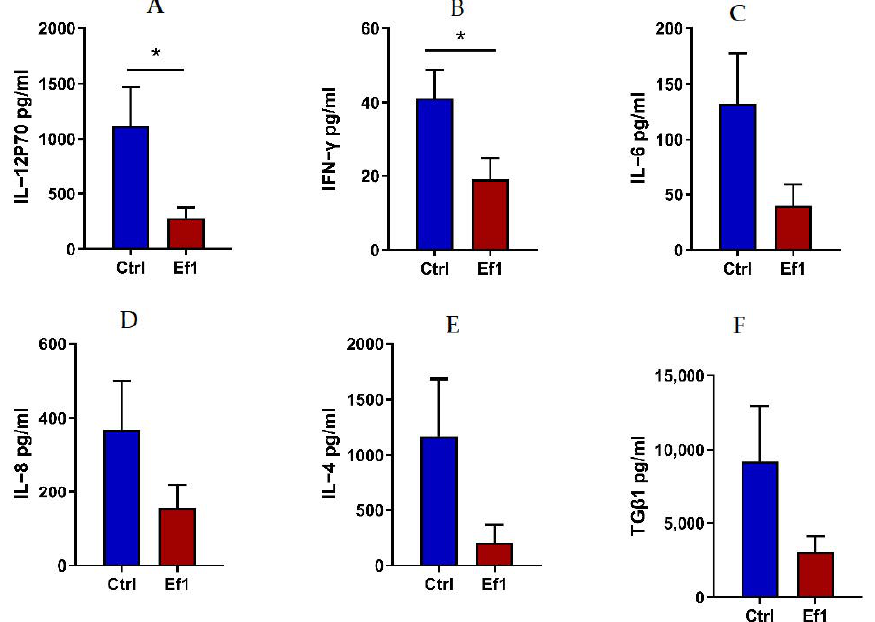
Figure 8. Effects of HDRsEf1 on inflammatory responses in serum. ( A – F ) The levels of inflammatory factors in serum, including IL-12, IFN- γ , IL-6, IL-8, IL-4, and TGF- β 1. Ctrl, control; Ef1, Enterococcus faecium HDRsEf1. Data are represented as mean ± SEM, n = 5, * p < 0.05.